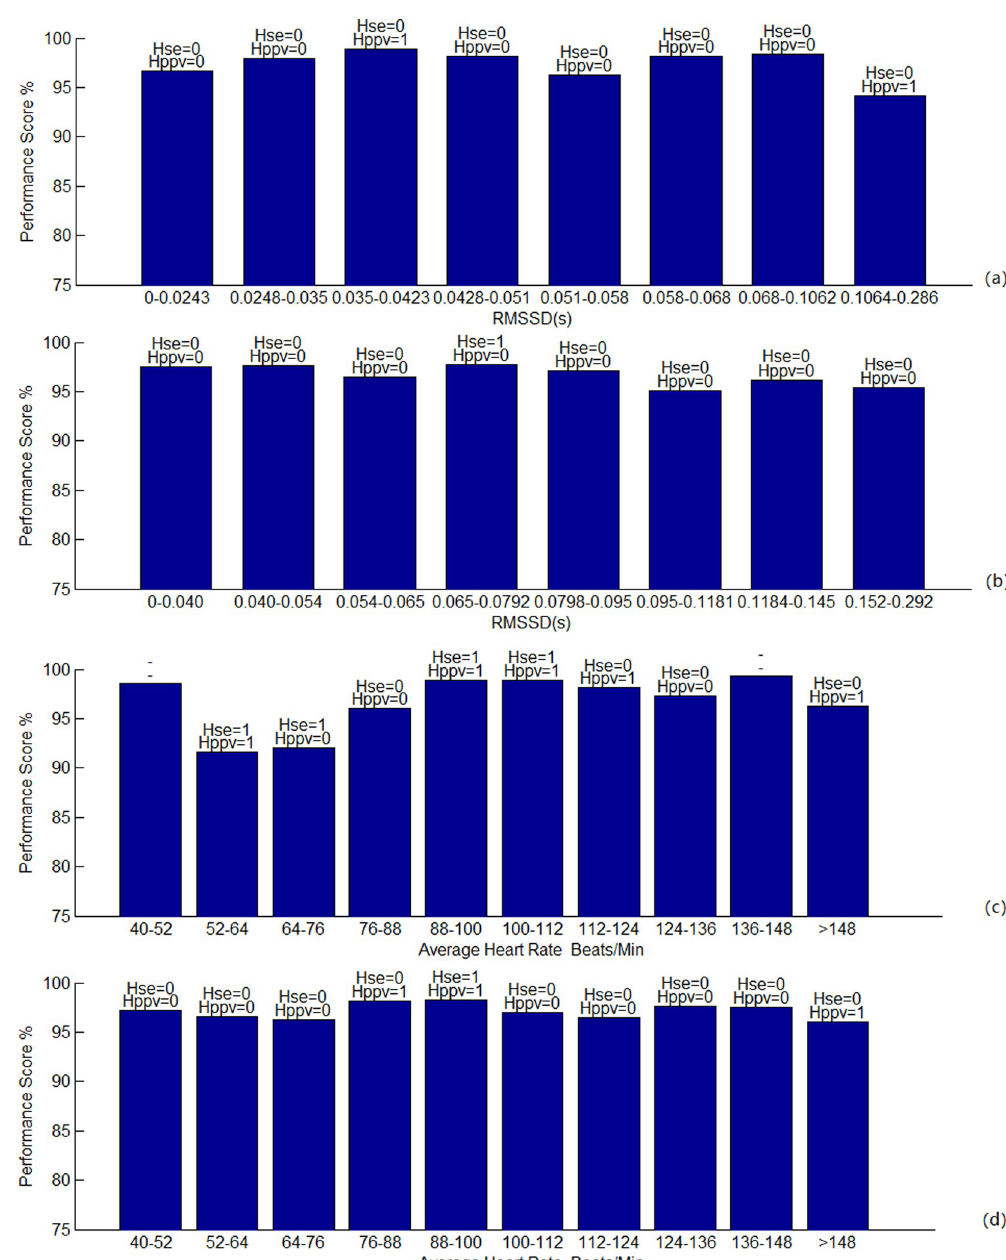
Fig 13. Performance scores of our proposed algorithm under different heart rate variabilities and average heart rates : (a) Different HRV for Challenge database; (b) Different HRV for MGH/MF database; (c) Different average heart rate for Challenge database; (d) Different average heart rate for MGH/MF